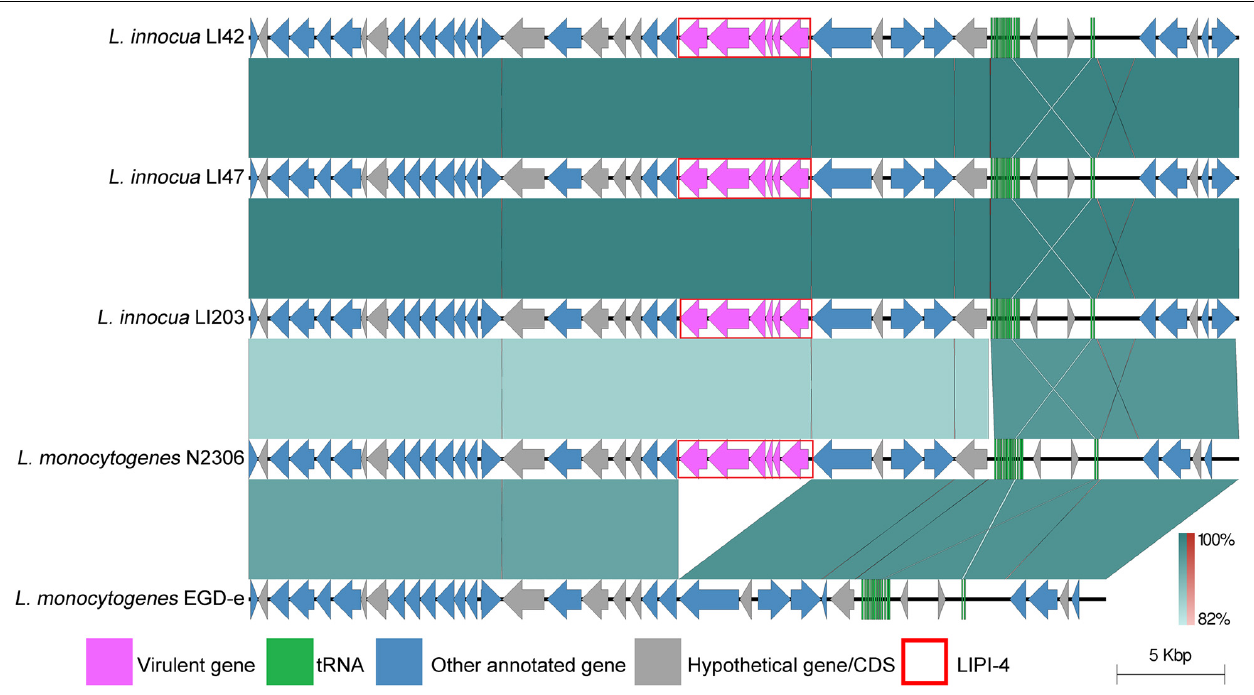
FIGURE 3 | Linear sequence comparison of LIPI-4 and its flanking regions. Sequences of LIPI-4 and their flanking regions on LI42, LI47, and LI203 genomes were compared with their ortholog in L. monocytogenes reference genome N2306 and EGD-e. Virulence genes were highlighted in pink arrows and LIPI-4 regions were marked in red frame. Green or red shades between each two sequences represented direct or inverted nucleotide identity between covered